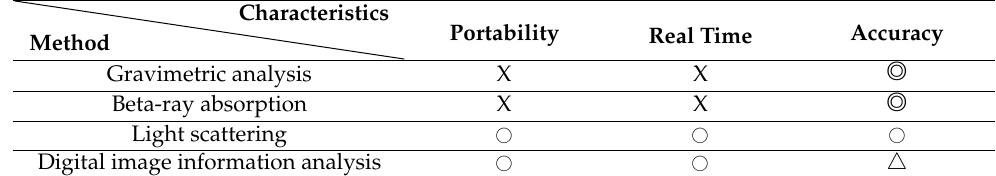
Table 2. Characteristics of PM measurement technology .